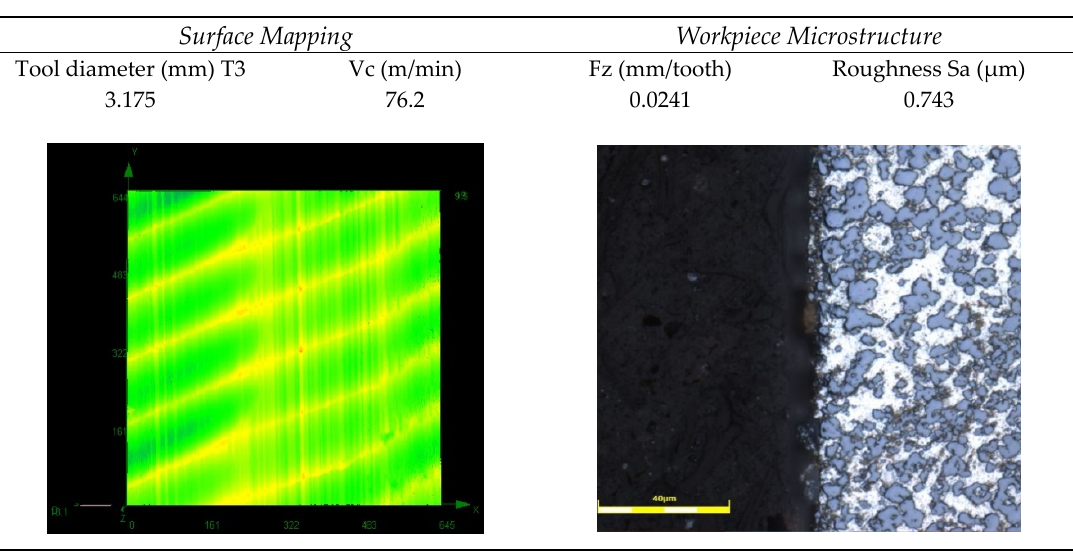
Figure 16. Surface map and microstructure (Tool 3).